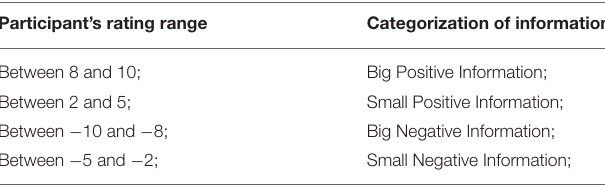
TABLE 2 | Categorization and selection of information based on participant’s rating score for each piece of information. Participant’s rating